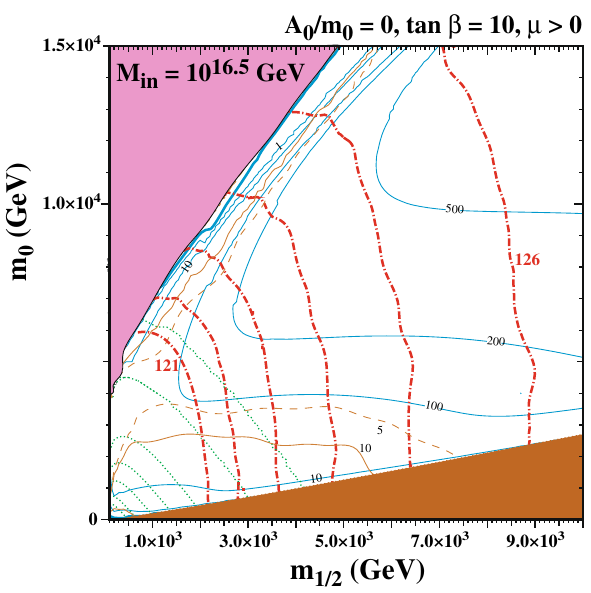
Fig. 1 A representative ( m 1 / 2 , m 0 ) plane in the flipped SU(5) GUT model, with M in = 10 16 . 5 GeV, tan β = 10 , A 0 = 0 ,λ 4 = 0 . 3 ,λ 5 = 0 . 1 and λ 6 = 0 . 0001. Regions with a stau LSP and without electroweak symmetry breaking are shaded brown and pink, respectively. The red dot-dashed curves are contours of the Higgs mass from 121–126 GeV in intervals of 1 GeV, as calculated using FeynHiggs 2.18.1 . The solid blue lines are contours of the relic density (cid:17) LSP h 2 = 0 . 1 , 1 , 10 , 100 , 200 , 500. A thicker contour with (cid:17) 2 = 0 . 1 is visible near the border of the no-electroweak symme- LSP h try breaking region, i.e., the focus-point region. The solid brown lines are where the central value of the p → e + π 0 lifetime is 10 36 years (labelled 10 in units of 10 35 years) and the dashed brown lines are = 5 × 10 35 years. The green dotted lines are contours where τ p − σ τ p of (cid:12) a μ = 1 , 2 , 5 , 10 , 20 , 50 , 100 × 10 − 11 , increasing as m 1 / 2 and m 0